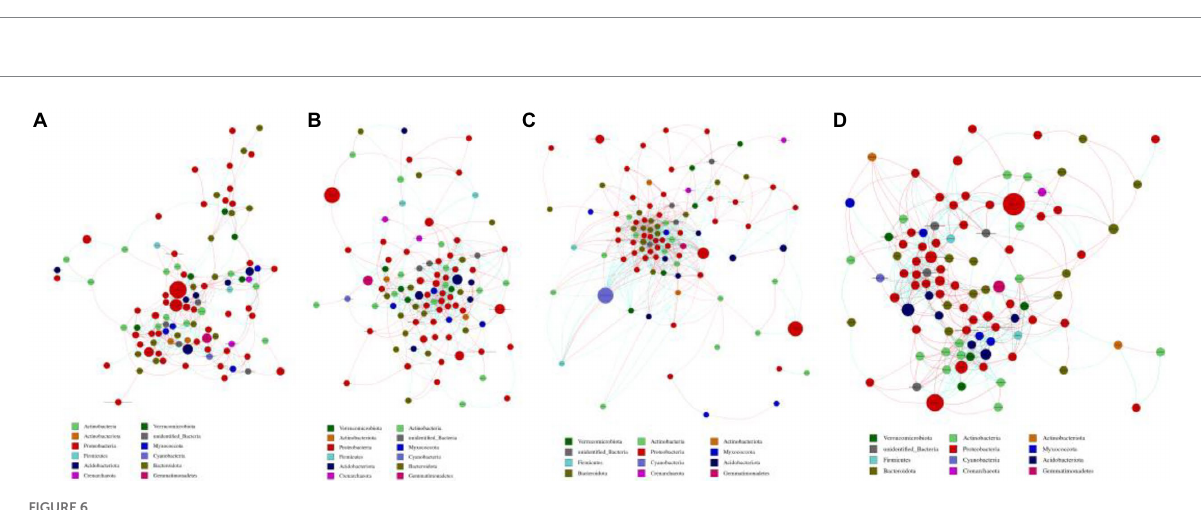
FIGURE 6 Co-occurrence network analysis of bacterial community in soybean soil. (A) is L10 at the R1 growth stage, (B) is L14 at the R1 growth stage, (C) is L10 at the R6 growth stage, (D) is L14 at the R6 growth stage. Different nodes represent different genera, node size represents the degree of connection of the genus, and the same color represents the same phylum level. The thickness of the connection between nodes is positively correlated with the absolute value of correlation coefficient of species interaction. The size of the node is proportional to the relative abundance of the phylum. Connections indicate significant correlation (Screening conditions: Spearman’s ρ > 0.6, p <